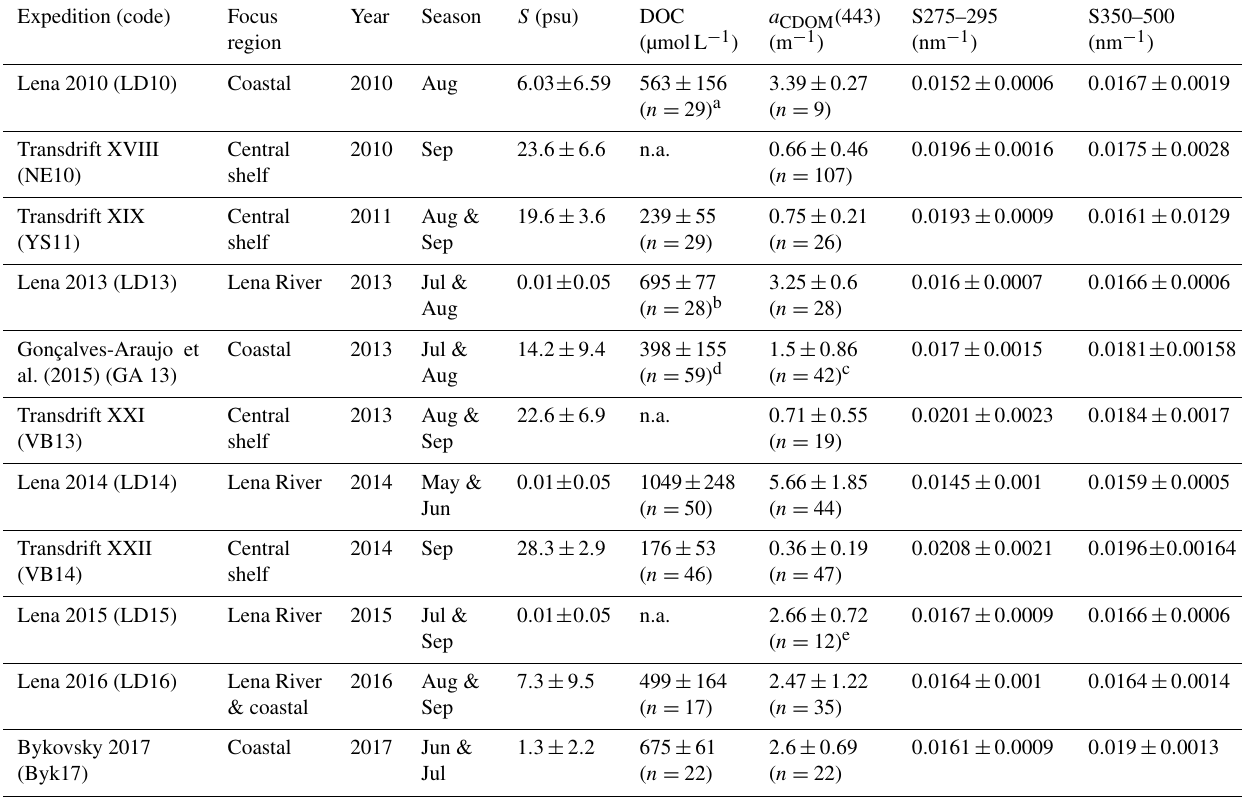
Table 1. Expedition focus regions, years and season. Mean and standard deviation of hydrographic and DOM parameters are listed. The number of samples between DOC and a CDOM (443) differs for some expeditions, and “n.a.” indicates that no DOC measurements were made.